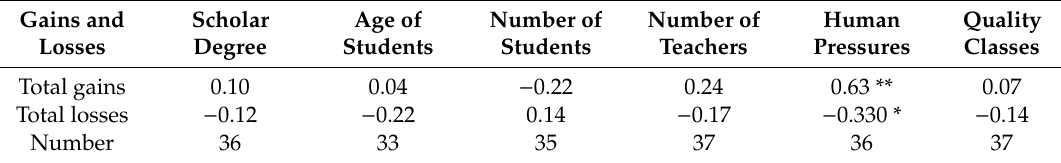
Table 5. Pearson correlation of the total audit (gains and losses) with the volunteer group characteristics, the human pressures (composite gradient), and the quality classes.